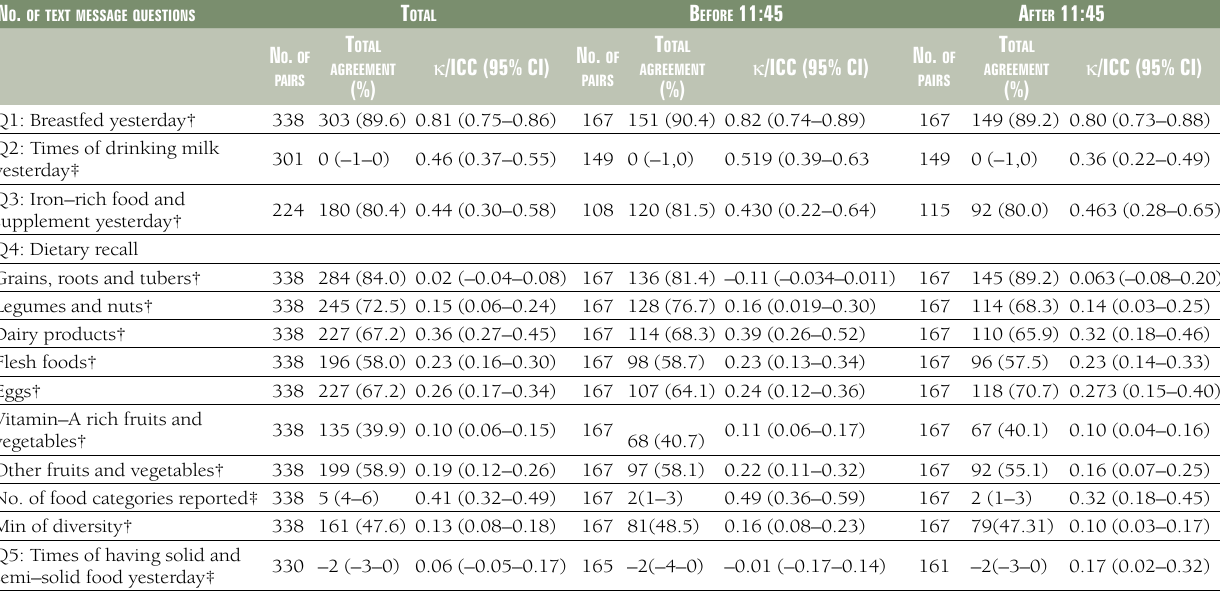
Table 3. Data agreement at different time intervals of the two surveys*